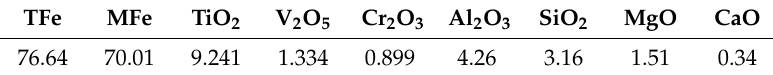
Table 5. Chemical composition of the metallized HCVTM pellet (wt %).